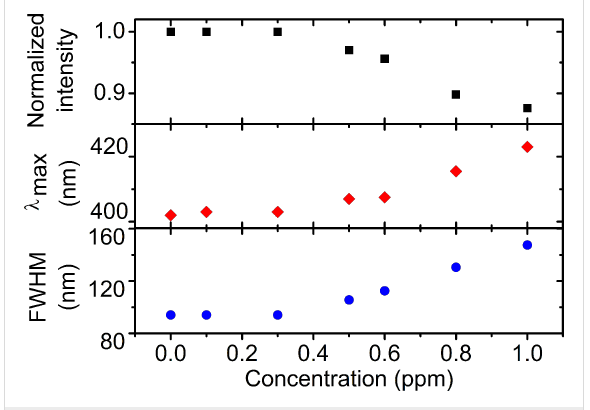
Figure 8: Normalized intensity, absorption maximum ( λ max ) and FWHM as a function of the nickel ion concentration.